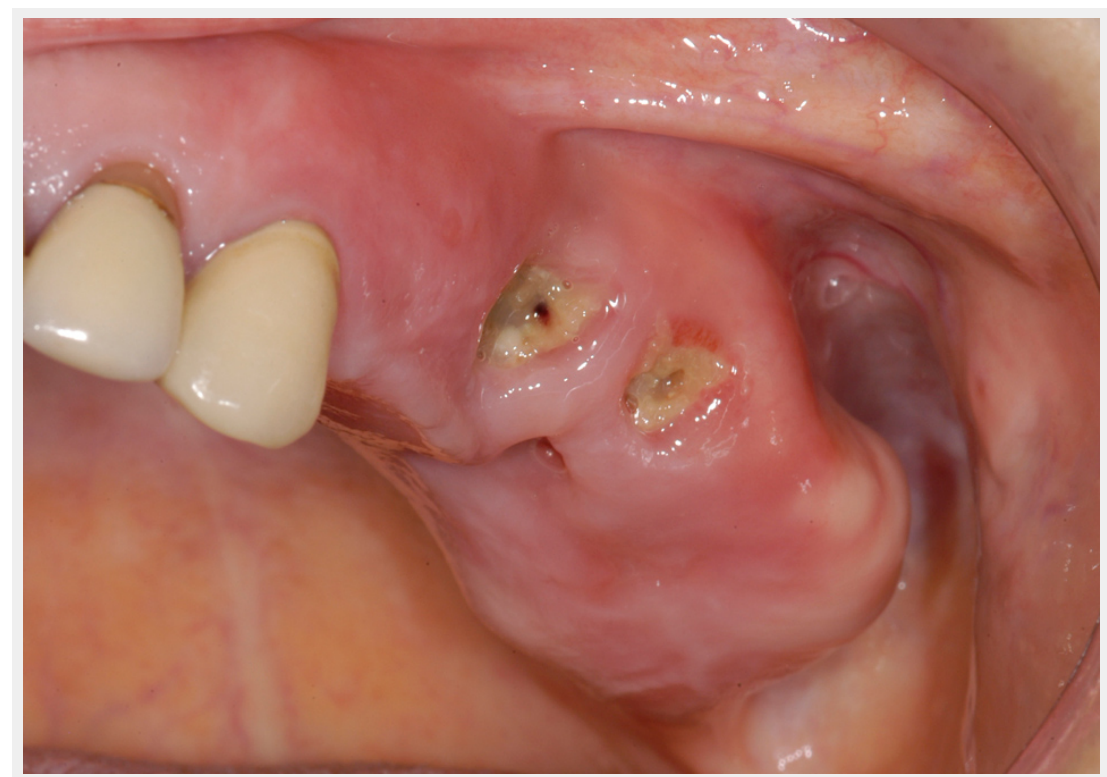
Female patient with osteoporosis and BRONJ of the left posterior maxilla including the maxillary sinus. The clinical picture shows exposed bone with signs of infection of the surrounding and pus